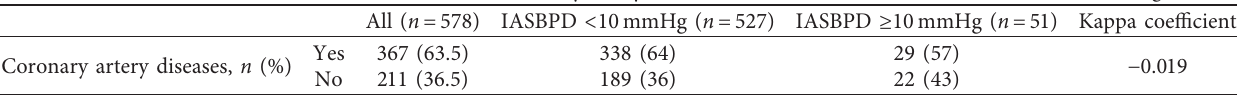
Table 3: Correlation between the existence of coronary artery diseases and IASBPD † of less and more than 10 mmHg.